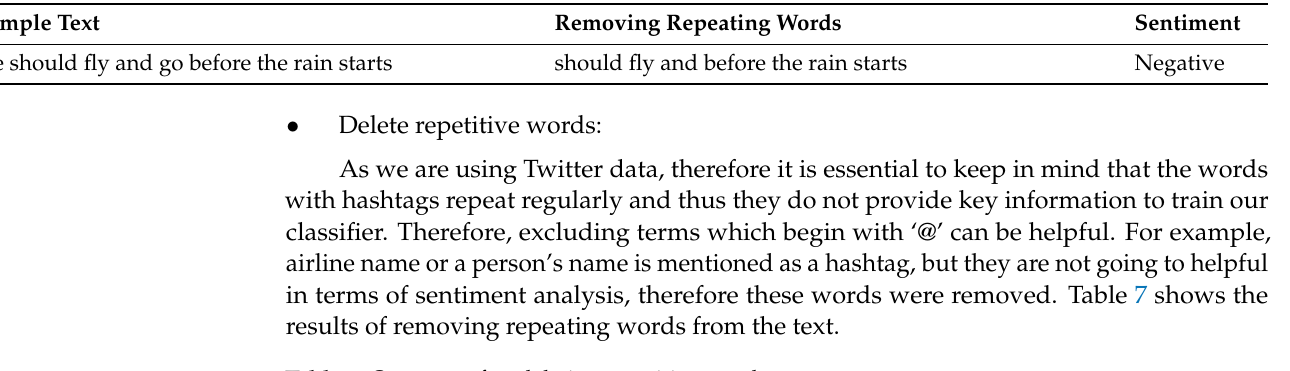
Table 7. Outcome after deleting repetitive words.